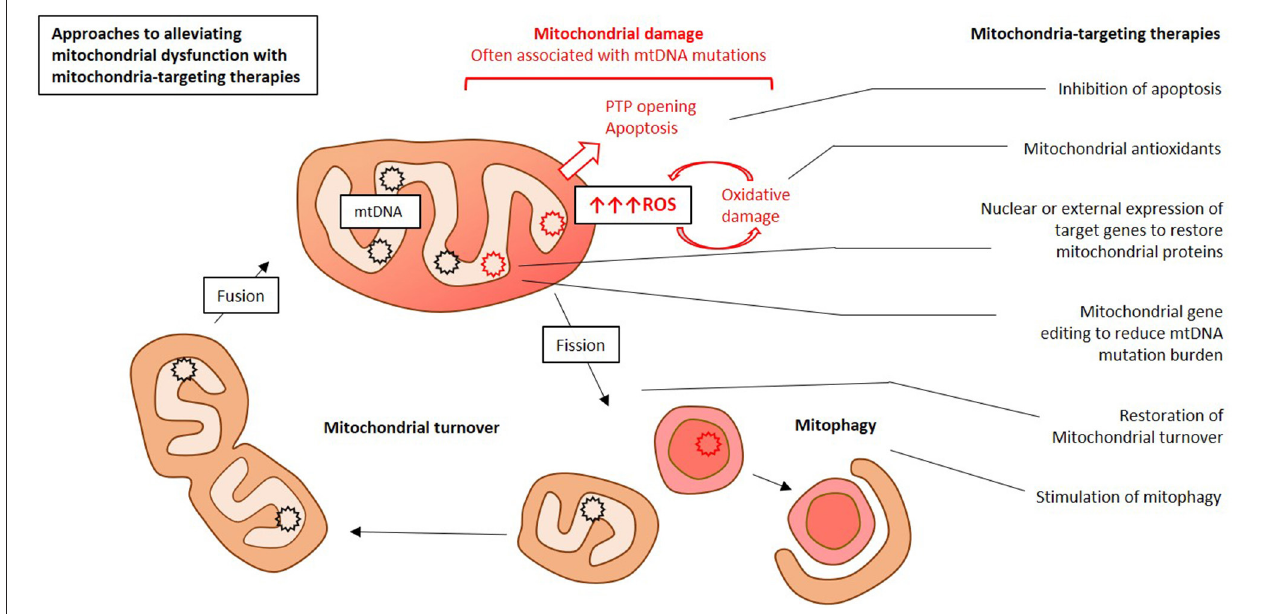
FIGURE 1 | Simplified presentation of main approaches to mitochondria-targeting therapy for atherosclerosis. This Figure was drawn by E. Ivanova in Microsoft